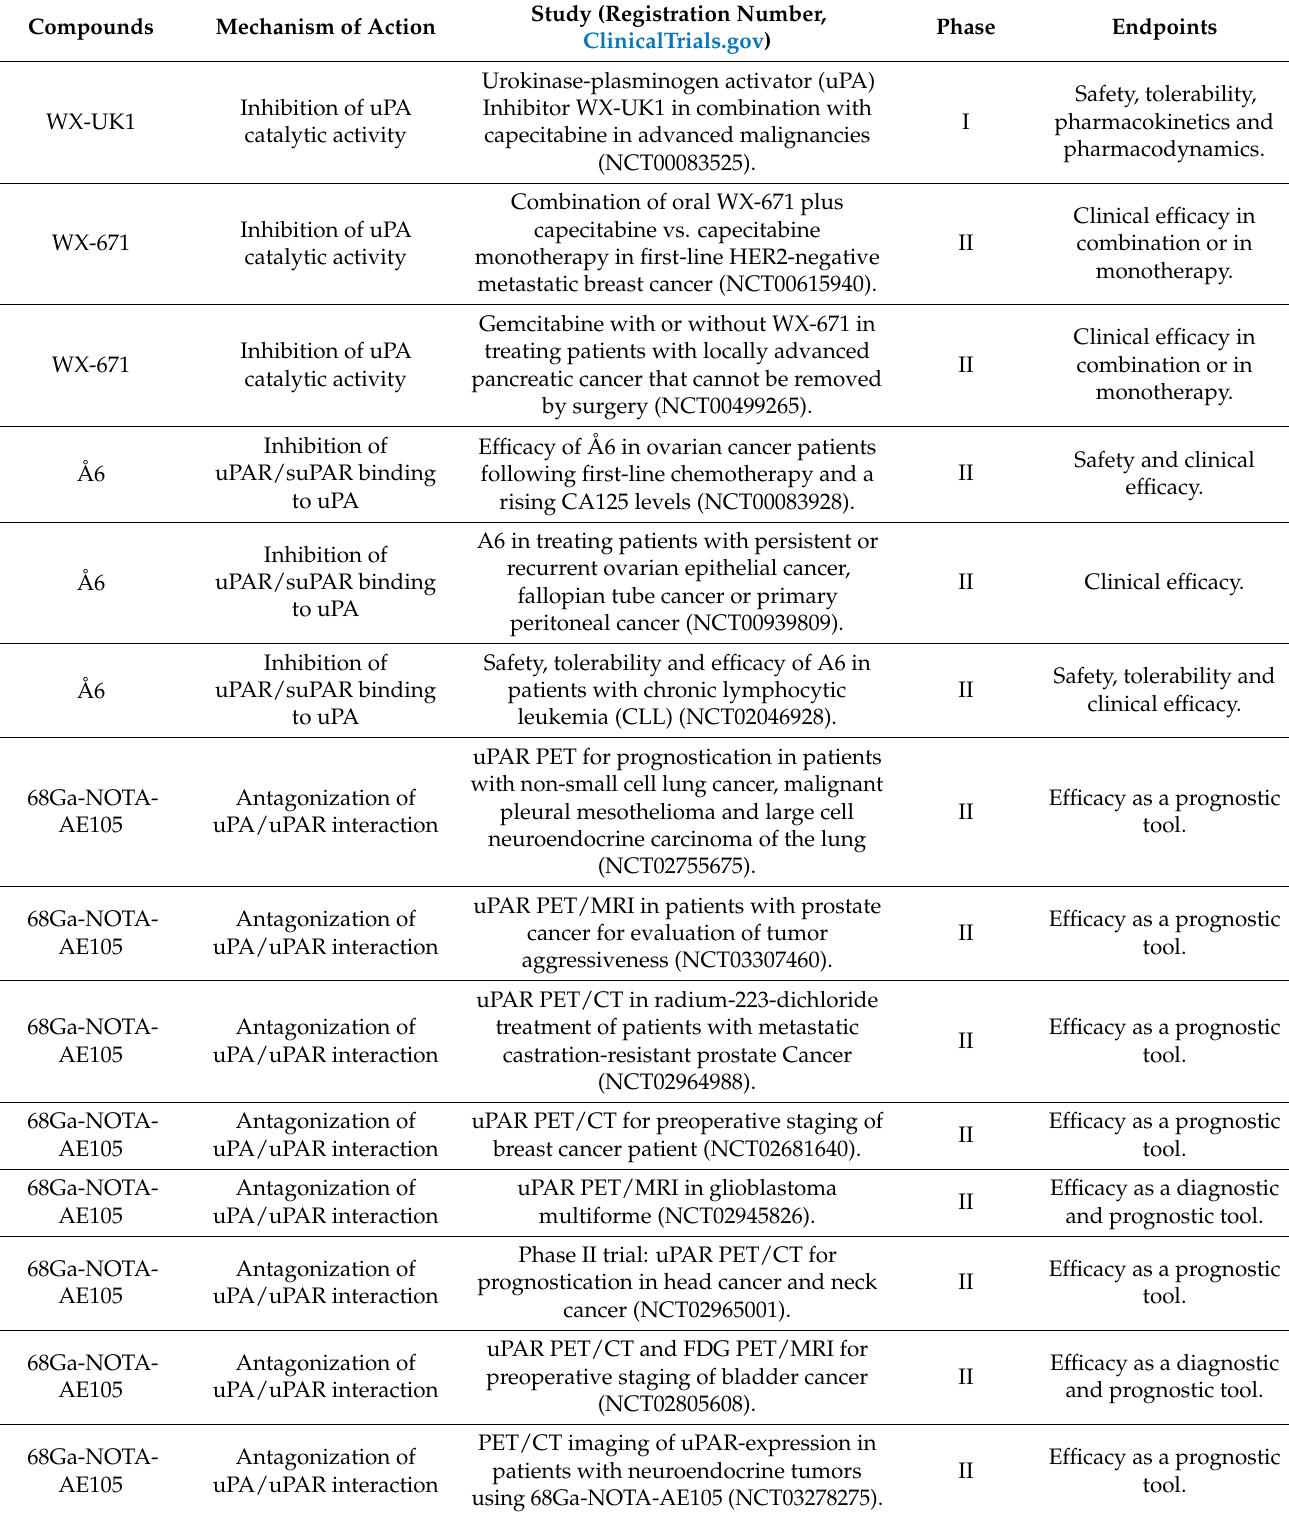
Table 1. Clinical trials with uPA/uPAR system